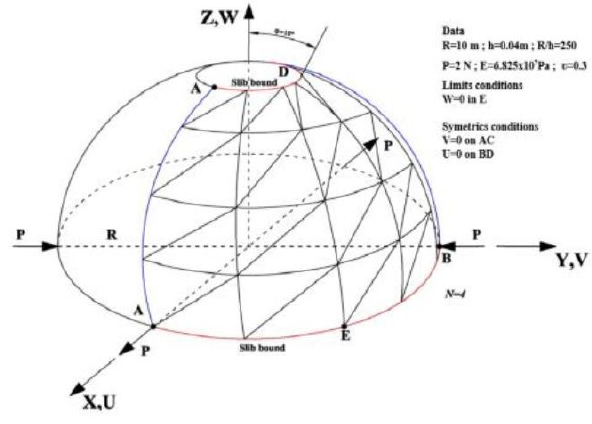
Figure 7: Hemisphere under diametrically opposite loads